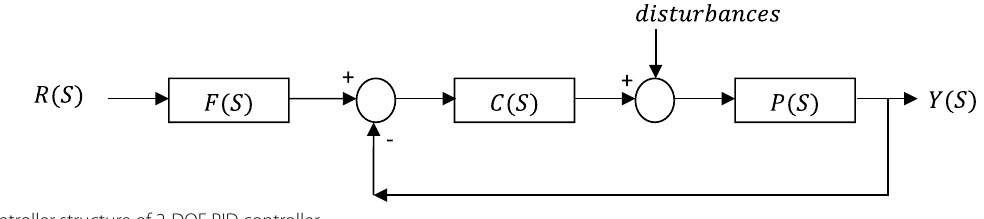
Fig. 2 Controller structure of 2-DOF PID controller